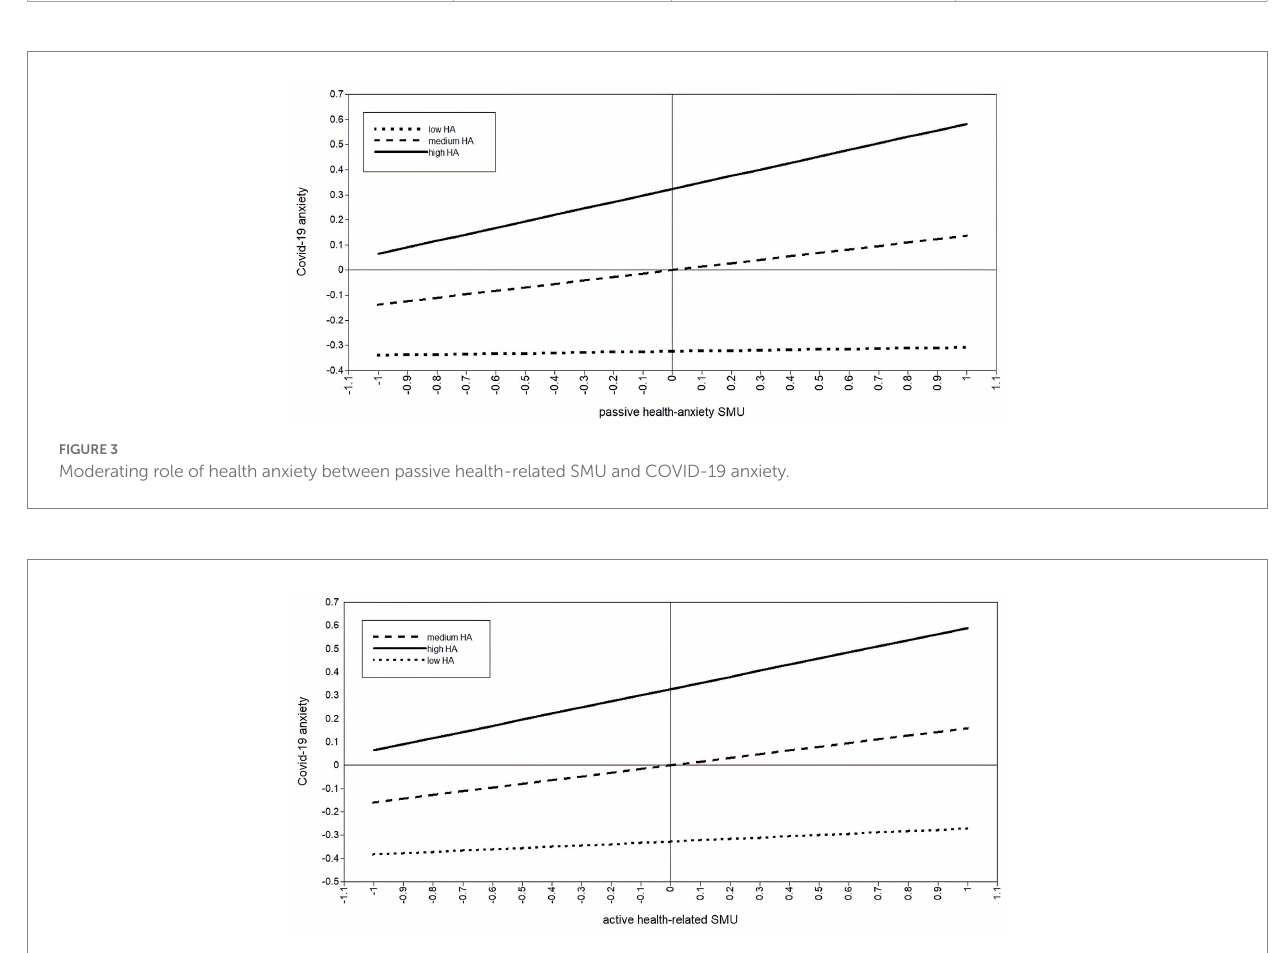
FIGURE 4 Moderating role of health anxiety between active health-related SMU and COVID-19 anxiety.